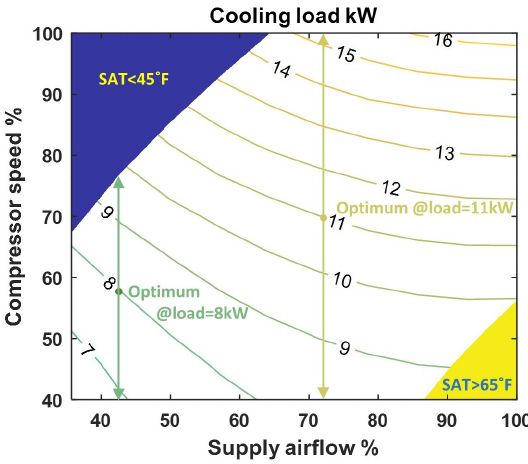
Figure 4. Illustration of the capacity reset